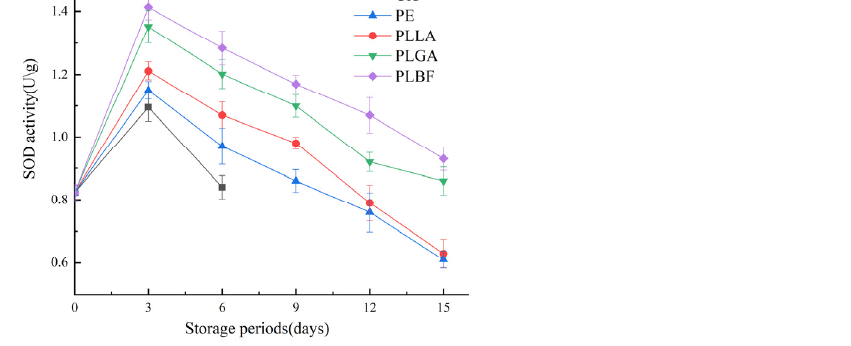
Figure 12. Changes of CAT activity of Agaricus bisporus in each packing group during storage. The CAT and SOD activities of PLBF were higher during storage. On the 15th day of storage, the CAT activities of the PE, PLLA, and PLGA groups were only 13 U/g, 15 U/g, and 20 U/g, and the SOD activities were only 0.61 U/g, 0.64 U/g, and 0.86 U/g, respectively, which were substantially weaker than those of the PLBF group. The CAT and SOD activities of the PLBF group were as high as 28 U/g and 0.93 U/g, respectively. These manifestations indicate that the gas fraction formed by PLBF (0.11% O 2 + 6.3% CO 2 ) can effectively maintain the activity of CAT and SOD, slow the oxidation and ageing process of Agaricus bisporus , and maintain the excellent quality of Agaricus bisporus . 3.2.7. Relevance Analysis Correlation analysis between the gas composition in the package and the quality of Agaricus bisporus was performed. As shown in Table 4, there was a close relationship between the gas composition in the package and the storage quality of Agaricus bisporus . In the results obtained, the O 2 concentration in the bag was highly significantly correlated with the TP of Agaricus bisporus ( p < 0.01) and with the BI and EC of Agaricus bisporus in the bag ( p < 0.05). The CO 2 concentration in the bag was highly significantly correlated ( p < 0.01) with BI and significantly correlated with TP, AA, MDA, EC, and SOD of Agaricus bisporus . In addition, O 2 inside the package had a strong correlation of − 0.924, 0.930, − 0.875, and − 0.901 with AA, MDA, CAT, and SOD of Agaricus bisporus , respectively, and CO 2 inside the package had a strong correlation of 0.931 with CAT of Agaricus bisporus . These results further suggest that regulating gas composition inside the pouch by changing the OTR and CDTR of PLLA-based films can further regulate the changes in postharvest